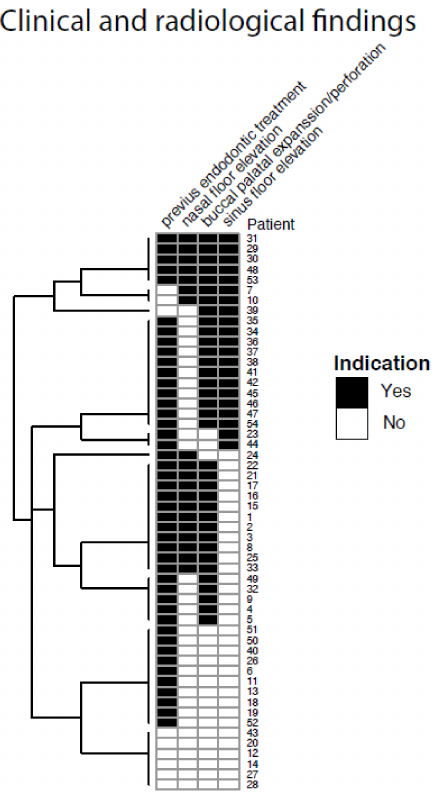
Figure 3. A cluster with representation of all patients clinical and radiological